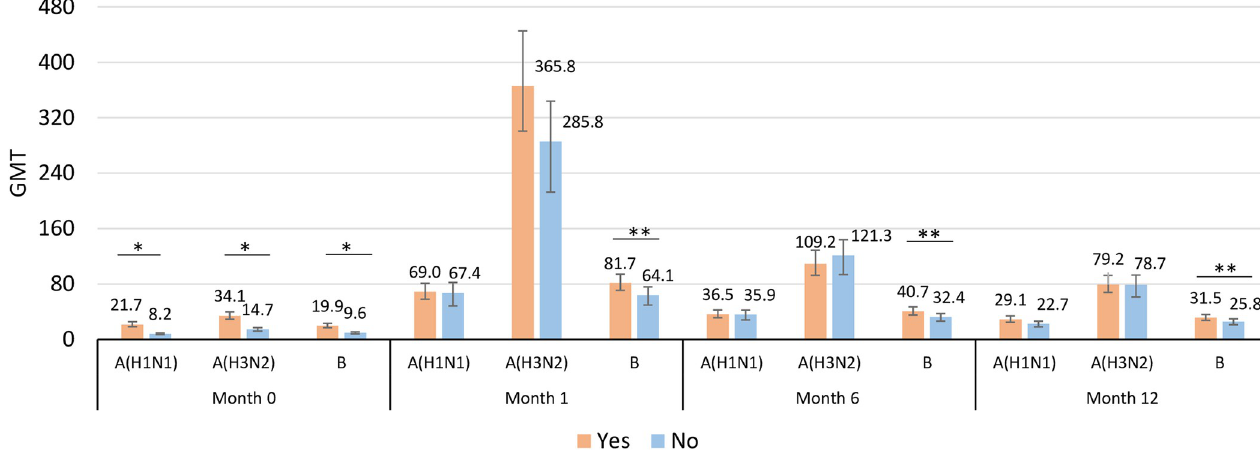
Fig 2. Geometric Meam Toter (GMT) among previously vaccinated group (Yes) and previously unvaccinated group (No) of IIV3 in 2014–2015 seson at study baseline 1-month, 6-month and 12-month follow-up. � Significance level p-value < 0.001, �� Significance level p-value < 0.05 from generalized linear model with identity function on logged transformed titer adjusted for age group and sex.